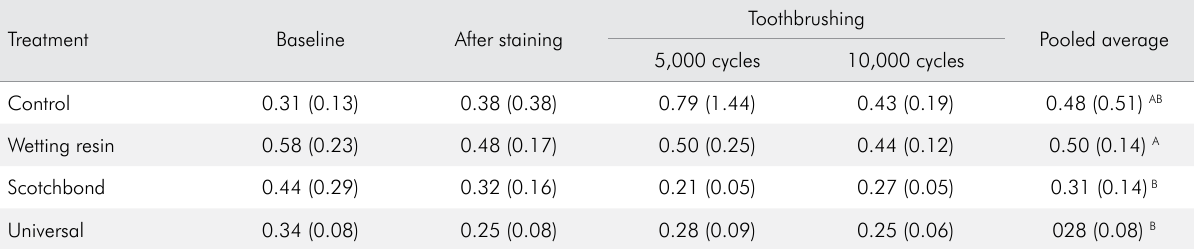
Table 2. Mean and standard deviation (SD) of Ra values according to treatment and assessment time intervalsa.